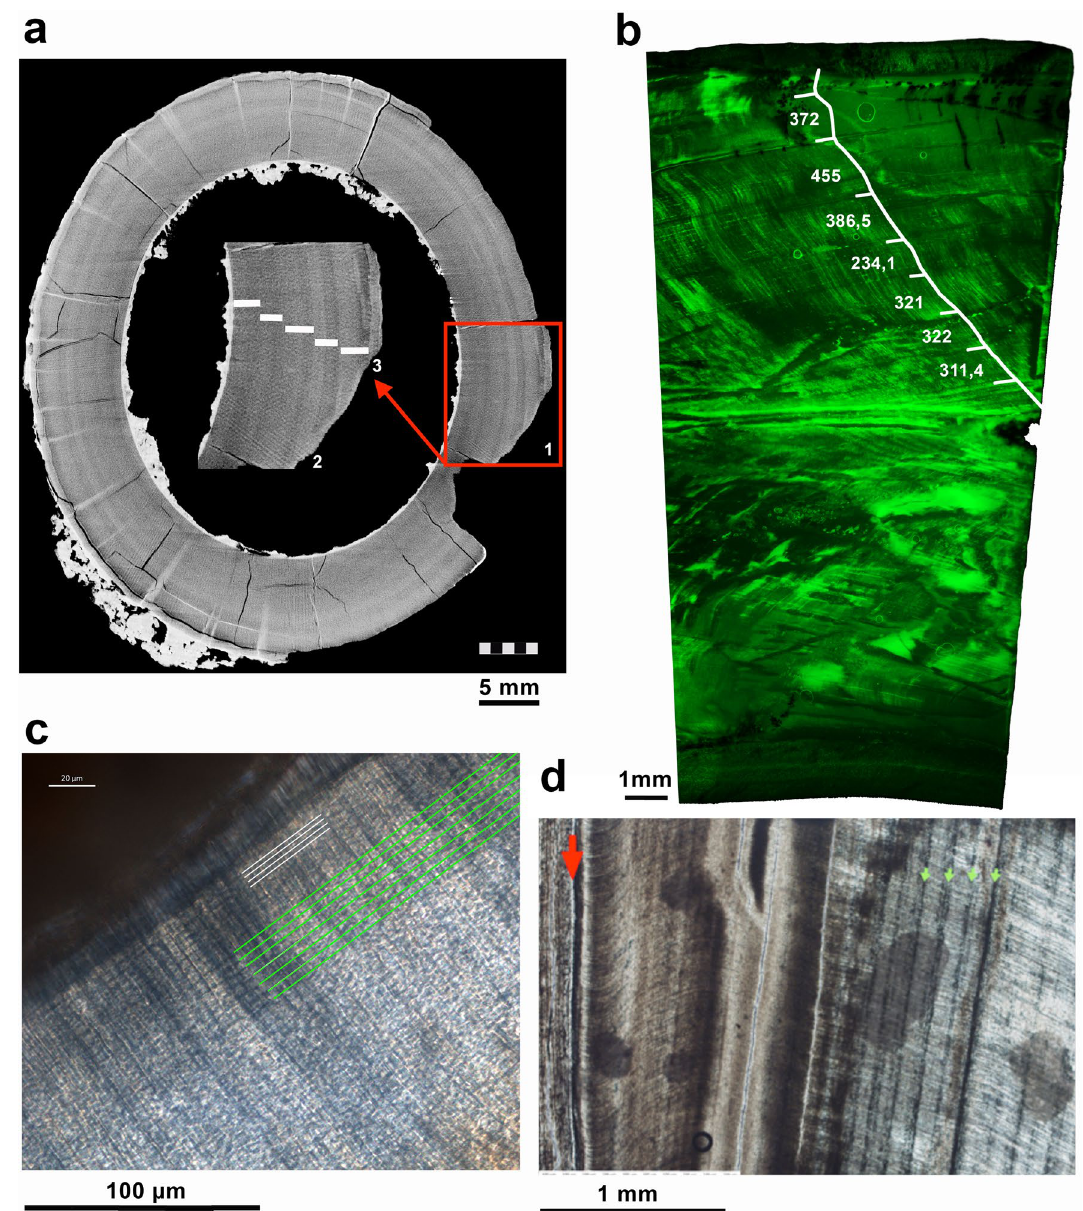
Figure 5. Tusk histology. ( a ) MicroCT—scan section of P. falconeri tusks. 1: Transversal microCT—scan section of CAT-102 tusk showing dark (winter) light (summer) bands; observe that the winter bands are thinner than summer bands. 2: magnification of (1) showing the last 5 annual incremental bands (pairs of dark–light dentine bands). 3: thin external cementum layer. ( b ) CAT-24 tusk (slide 24 B2-L1-110305.1) under green fluorescence light (for better visibility of the structures); measurements were taken between daily cross striations to calculate mean daily secretion rate (DSR); white line: prism; the prism was carefully followed as it decussated to estimate the days along the prism between the annual increments; white bars: key annual FOIs; the calculated number of days (white numbers) confirms the annual nature of the increments; Zeiss Scope.A1 microscope fluorescence light. ( c ) tusk 5 (slide 5-2–4) exemplifies the arrangement of daily increments (parallel green lines) and sub-daily increments (white lines) deposited along the border of the pulp cavity (dark area upper left). ( d ) CAT 100 tusk with monthly (second-order) increments; red arrow: cementum-dentine junction; ( b ) green arrows: second- order increments. Zeiss Scope A1 microscope with integrated digital camera (AxioCam